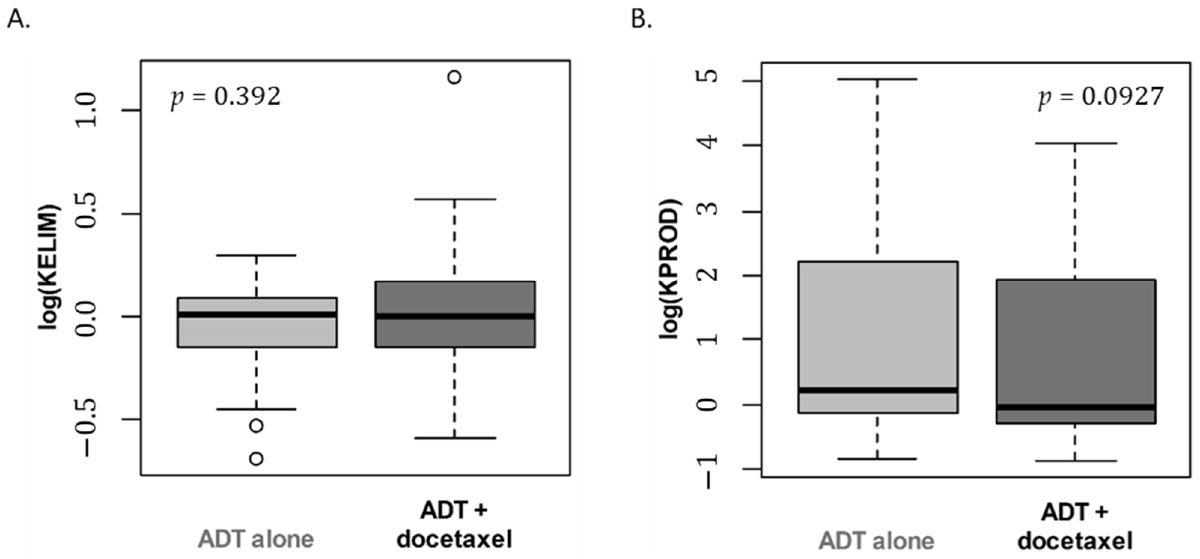
Figure 3. Boxplot of standardized KELIM ( A ) and KPROD ( B ) individual estimations according to treatment arm (logarithm scale). Wilcoxon test p -values.